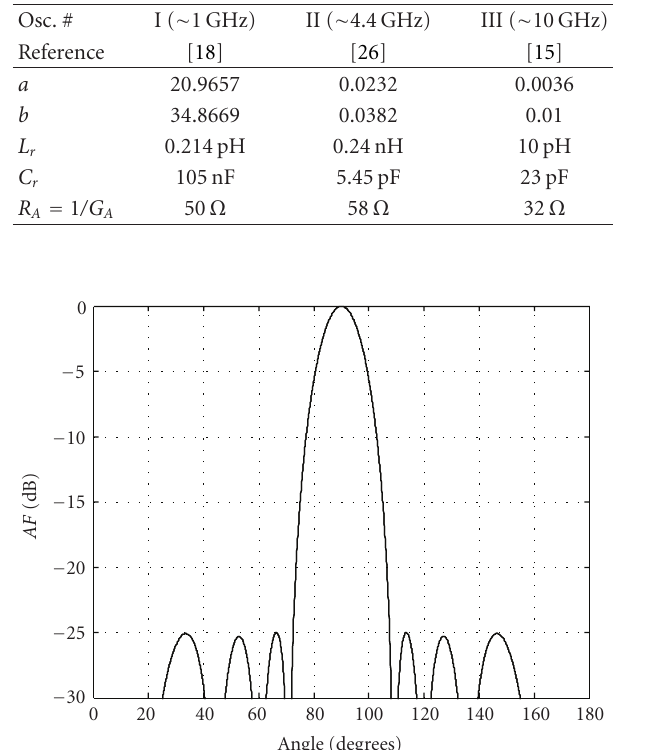
pattern is a Chebyshev one with HPBW = 15 degrees and SLL = − 25 dB. We start from an array of 9 elements with uniform initial excitation and 0 . 45 λ interelement distance. We apply the synthesis method for three di ff erent cases. In case A, the excitations and the positions are to be derived. In case B, the phase of the excitations is set equal to zero, and in case C , the amplitude of the excitation is equal to unit.